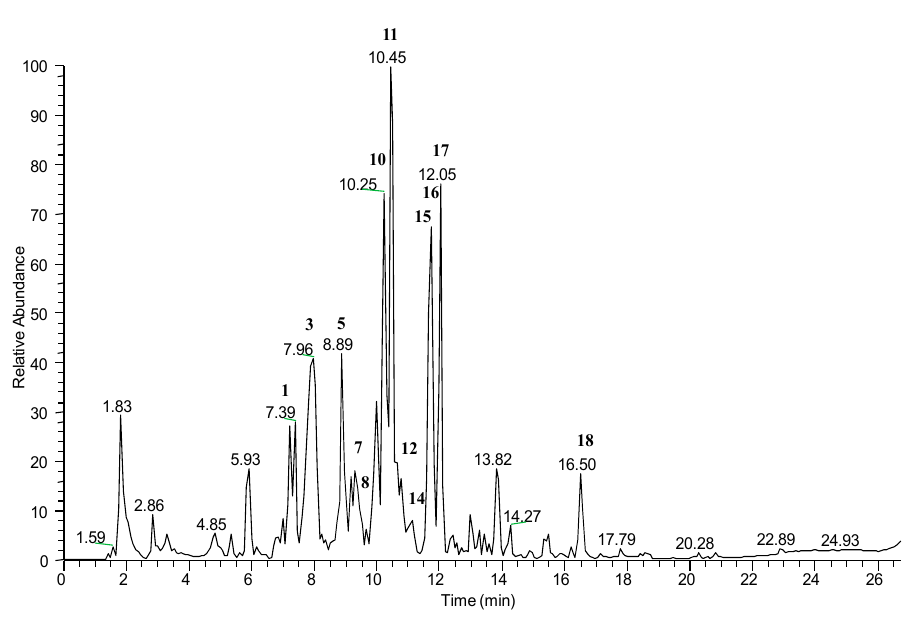
Figure 3. LC-ESI/LTQOrbitrap/MS profile in negative ion mode.